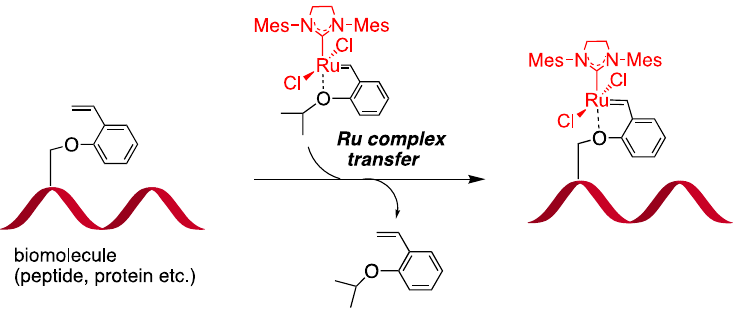
Scheme 8. Ruthenium complex transfer onto biomolecules based on ligand exchange.